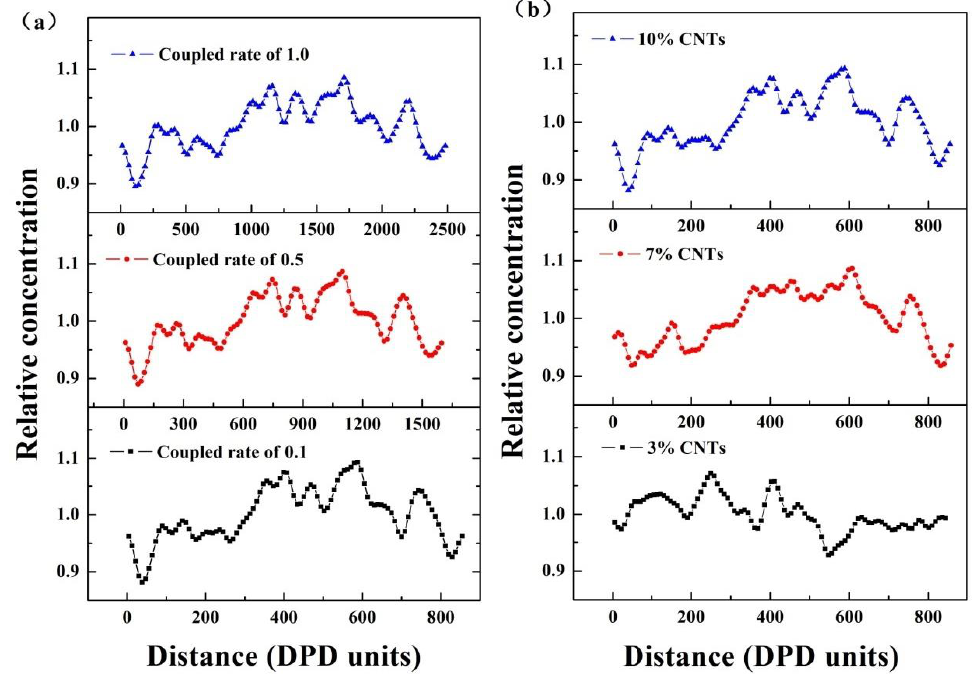
Figure 6. The relative concentration of CNTs in CNTs/UHMWPE composites along the Z direction (frames to average) related to: ( a ) different extensional-shear coupled rates and ( b ) CNTs concentrations.